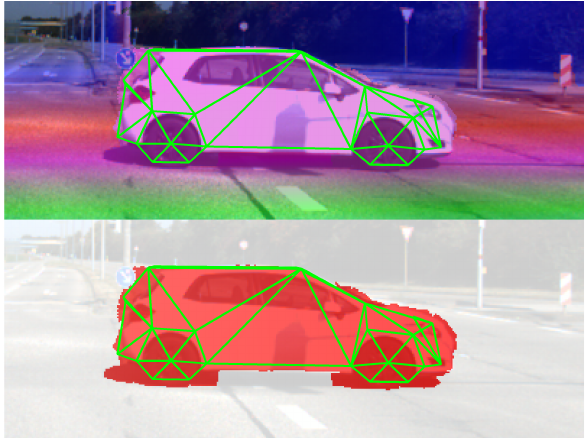
Figure 1. Result of Model-based Reconstruction. The green wire-frame representation is superimposed to the inferred dispar- ity (top) and optical flow map